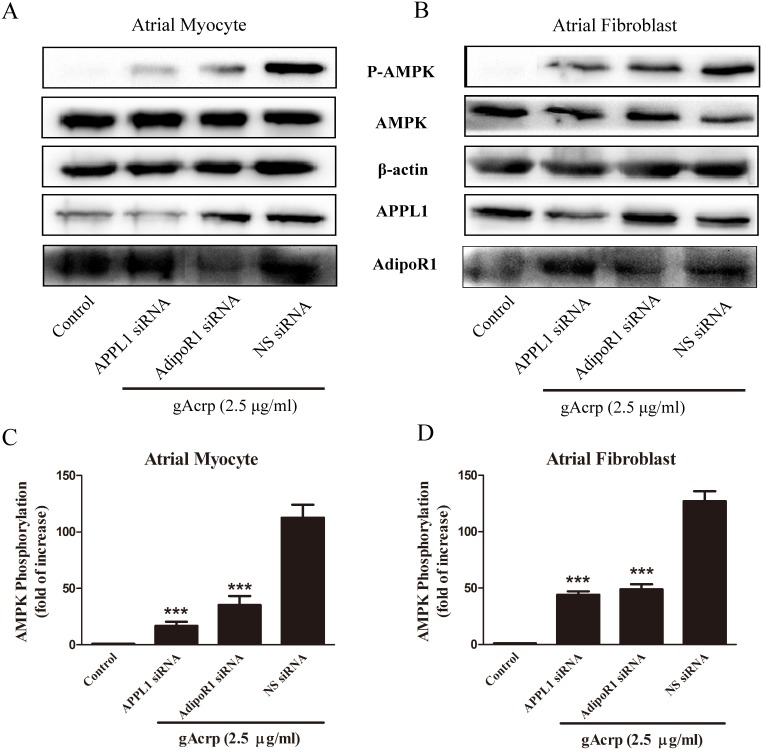
Involvement of APPL1 and AdipoR1 in AMPK activation after treatment with gAcrp in cultured atrial myocytes and fibroblasts.(A) After atrial myocytes were incubated with APPL1, AdipoR1 and non-silencing (NS) siRNA for 24 h, interference group treated with gAcrp (2.5 µg/ml) for 1 h. The expression of AMPK, pAMPK and APPL1 was determined by Western blotting. β-actin was used as an internal control. (B) After atrial fibroblasts were incubated with APPL1, AdipoR1 and non-silencing (NS) siRNA for 24 h, all the groups treated with gAcrp (2 µg/ml) for 1 h. (C) and (D) Quantitative analysis of AMPK phosphorylation shown in the upper panel was performed by densitometric analysis. Data were expressed as mean ± SD of three independent experiments. ***P<0.001 vs. NS siRNA control with gAcrp.